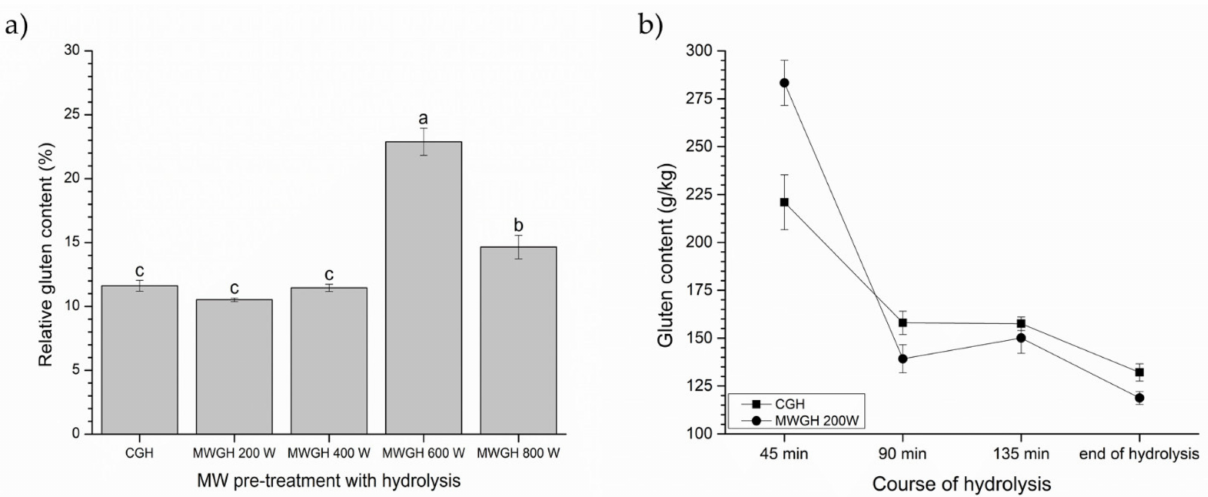
Figure 3. ( a ) Relative gluten content (%) of the control gluten hydrolysis (CGH) and microwave pretreated gluten hy- drolysates (200–800 W) (Alcalase, pH 8, 60 ◦ C) compared to untreated gluten (100%) and ( b ) gluten content reduction (g/kg) during hydrolysis, CGH and MWGH 200 W. Results are expressed as mean ± standard deviation ( n = 2). Means with different letters in the same figure are significantly different ( p <